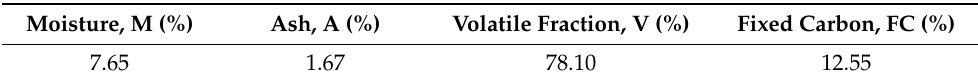
Table 3. Proximate analysis of pine wood.